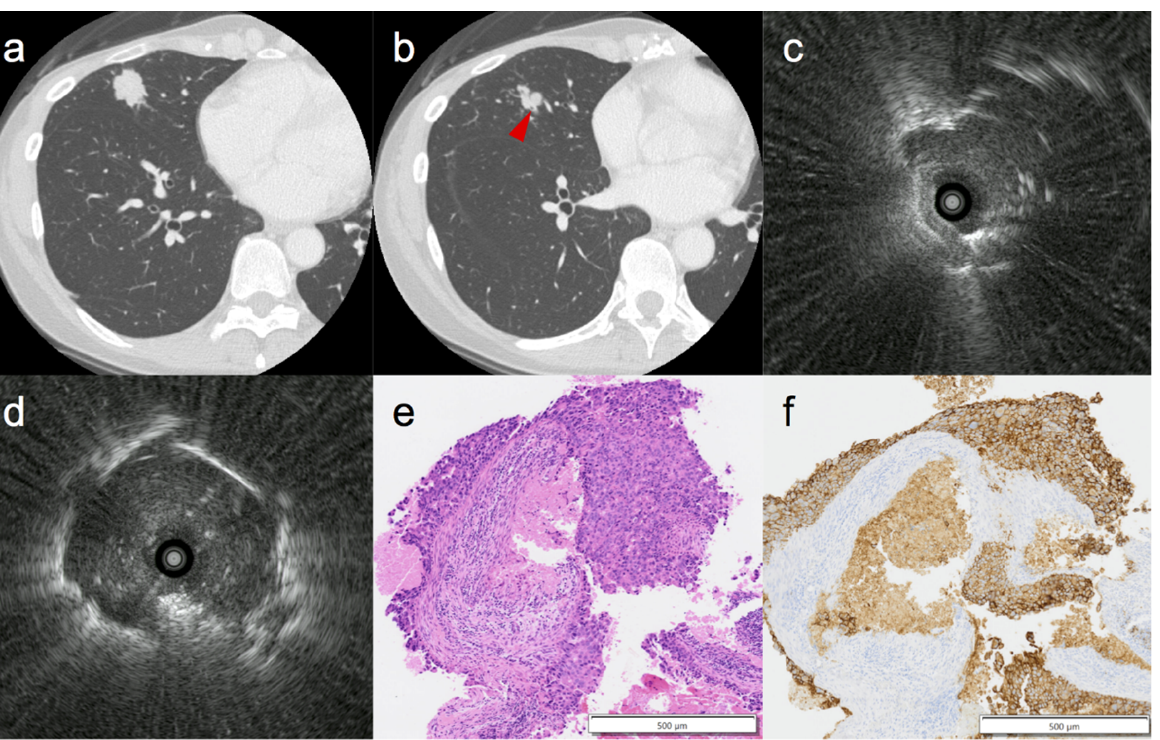
Figure 1. Representative case of a 48-year-old female for whom needle aspiration was effective. ( a ) High-resolution computed tomography showing a solid nodule 19.8 mm in size in the middle lobe. ( b ) Proximal side of the lesion indicating a positive bronchus sign (arrowhead). ( c ) Initial radial endobronchial ultrasound (R-EBUS) findings showing “adjacent to” the lesion. ( d ) After needle aspiration, the R-EBUS finding changed to “within” the lesion. ( e ) Hematoxylin and eosin staining (×40) depicting adenocarcinoma. ( f ) Positive immunohistochemical staining for ERBB2 (×40) similar to the primary lesion, with a diagnosis of metastasis of breast cancer.